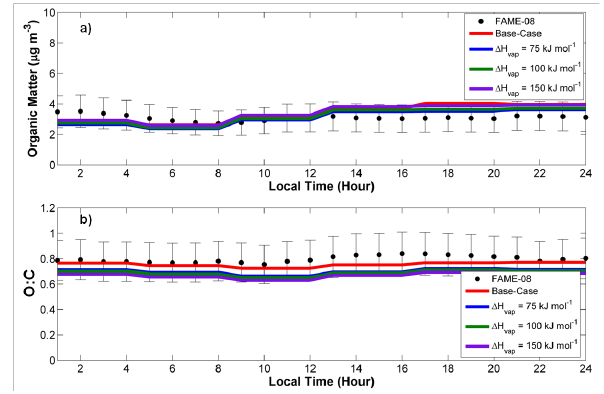
978 Figure 7. a) Organic aerosol mass concentrations and b) O:C with several choices for 979 Fig. 7. (a) Organic aerosol mass concentrations and (b) O:C with anthropogenic and biogenic volatile SOA enthalpy of vaporization in the 2D-VBS configuration. 980 several choices for anthropogenic and biogenic volatile SOA en- thalpy of vaporization in the 2D-VBS configuration. All values are All values are diurnally averaged for the 9 simulated days during FAME-08. Errors bars 981 diurnally averaged for the 9 simulated days during FAME-08. Er- correspond to the measurements uncertainty. 982 rors bars correspond to the measurements